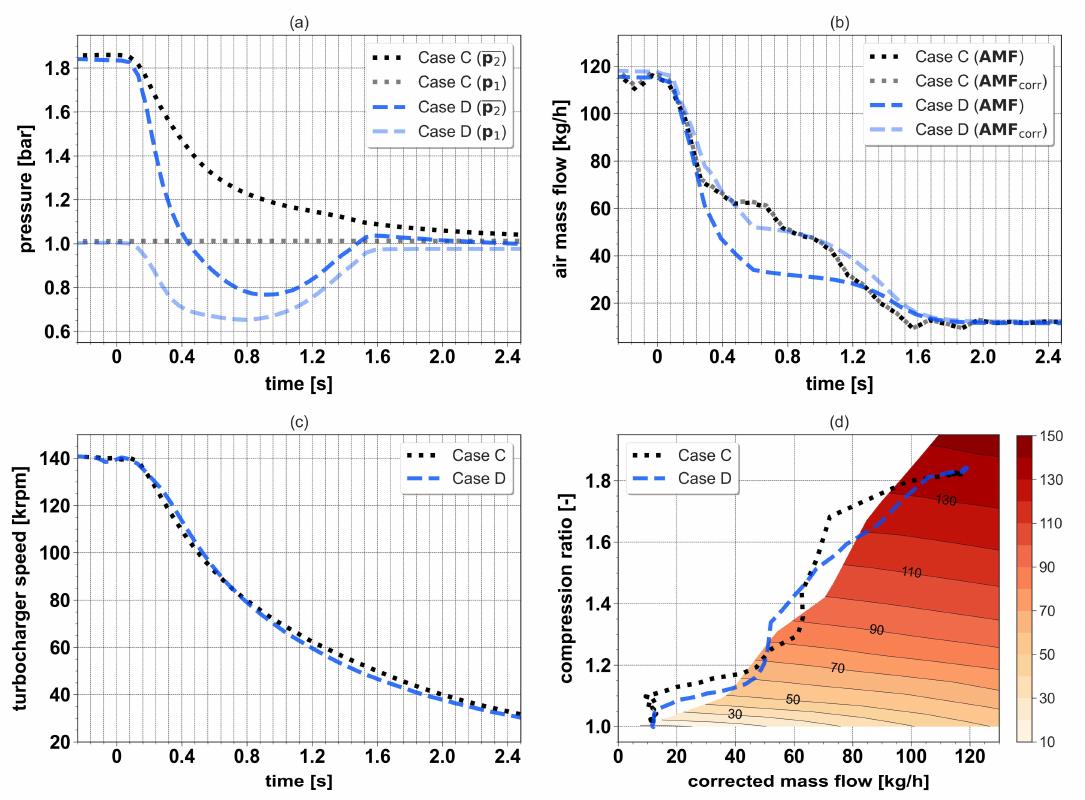
Figure 7. Time evolution of compressor inlet and outlet pressure ( a ), air mass flow at filter outlet along with its corrected values ( b ) and turbocharger speed ( c ), and operating path on the compressor speed map ( d ) for Cases C and